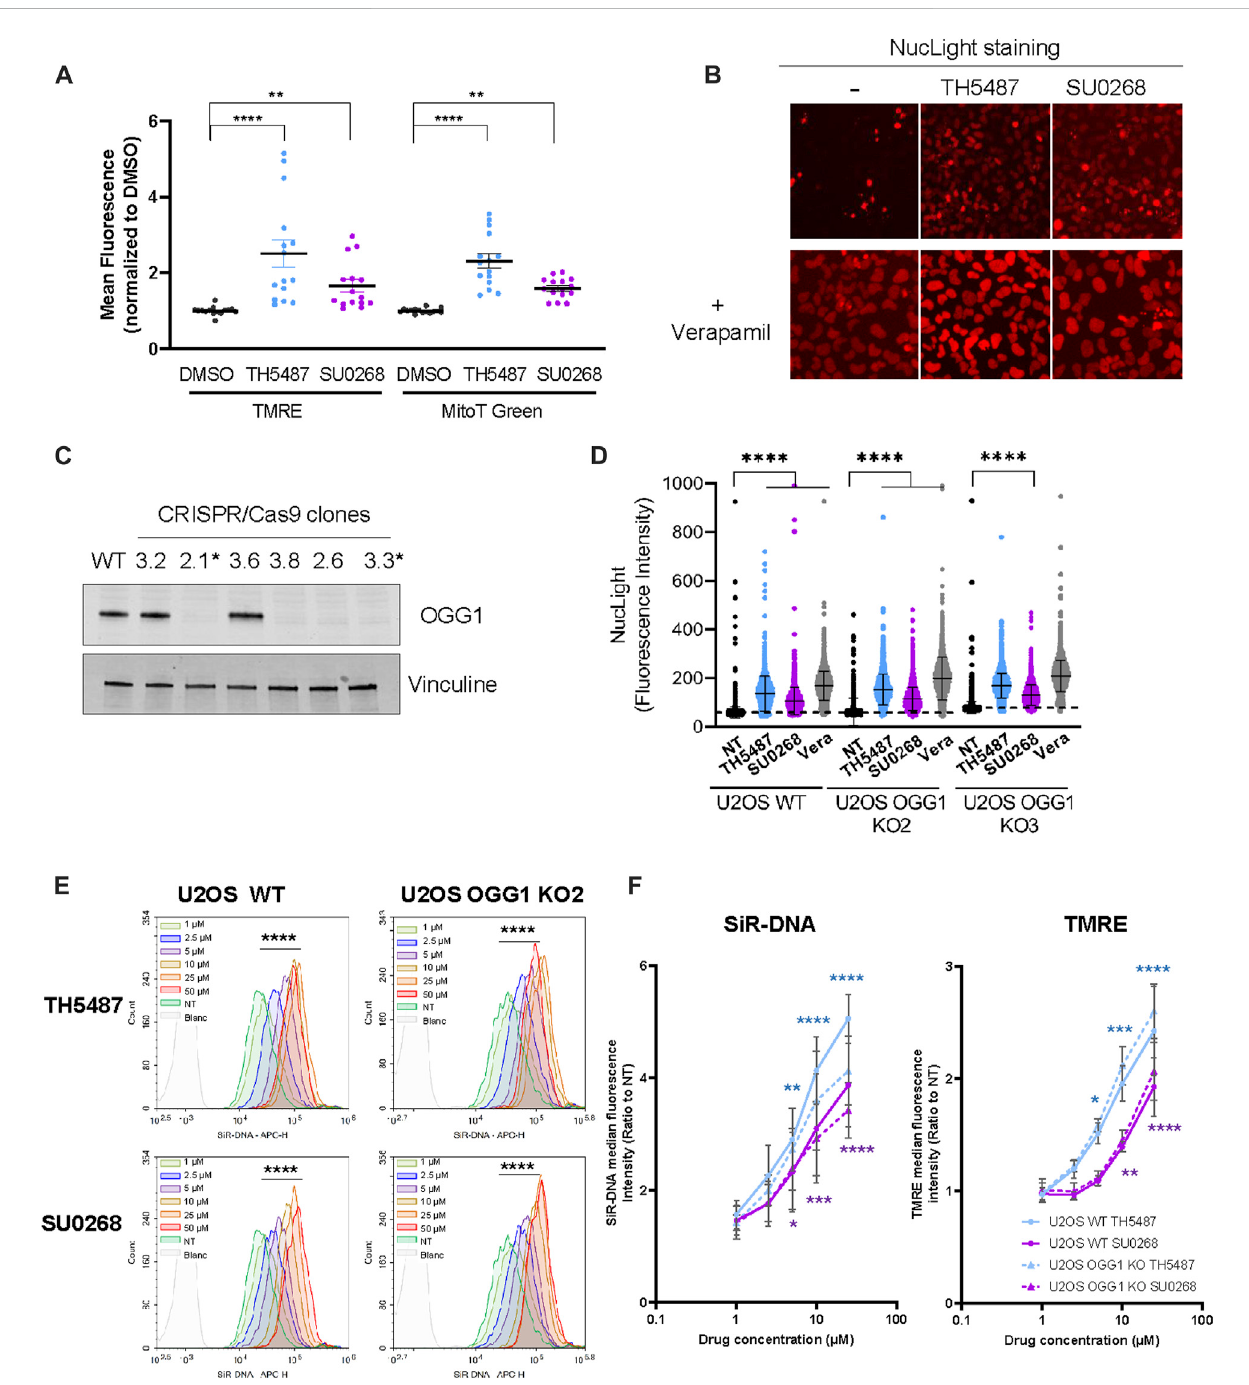
The addition of OGG1 competitive inhibitors TH5487 and SU0268 to the medium results in higher staining with fl uorescent dyes. (A) U2OS cells were stainedwith mitochondrialmarkers MitoTracker Greenand TMRE inthepresence of10 µMofOGG1inhibitors TH5487orSU0268.Controlcellswerestained in DMEM containing DMSO at .1%. Fluorescence was acquired in a plate reader. Fluorescent intensity for each of the channels was normalized to the values measured in cells stained in control cells. Ploted values correspond to at least three technical replicates from four independent experiments. Statistical analysis was performed with a Kruskal-Wallis test. (****) p < 0.0001; (**) p < 0.005. (B) U2OS cells were stained with NucLight in the presence or absence of OGG1 inhibitors TH5487 and SU0268 combined or not with Verapamil (A) and imaged with the Incucyte ® Live-Cell Analysis System. (C) OGG1 KO cells generated by CRISPR/Cas9 were validated by Western Blot analysis using an antibody against OGG1. Vinculine was used as a loading control. Clones 2.1 and 3.3wereselectedandusedinfurtherexperiments. (D) U2OSWTandOGG1KOcells,werestainedwithNucLightandPicogreeninthepresenceorabsenceof OGG1inhibitorsorVerapamil(all usedat10 µM)andimaged withahigh-content imagingmicroscopeinboththegreen andtheredchannels. Representative imagesusedforthequanti fi cationarepresentedinFigureS1.ThegraphcorrespondstotheNucLight fl uorescenceintensitymeasuredinthenucleusforupto 7000 cells for each condition. One representative experiment out of three is presented. Statistical analysis was performed with a Kruskal-Wallis test. (****) p < 0.0001. (E) U2OS WT and OGG1 KO cells were stained with SiR-DNA in the presence of different concentrations of TH5487 and SU0268 (1, 2.5, 5, 10, 25 or ( Continued